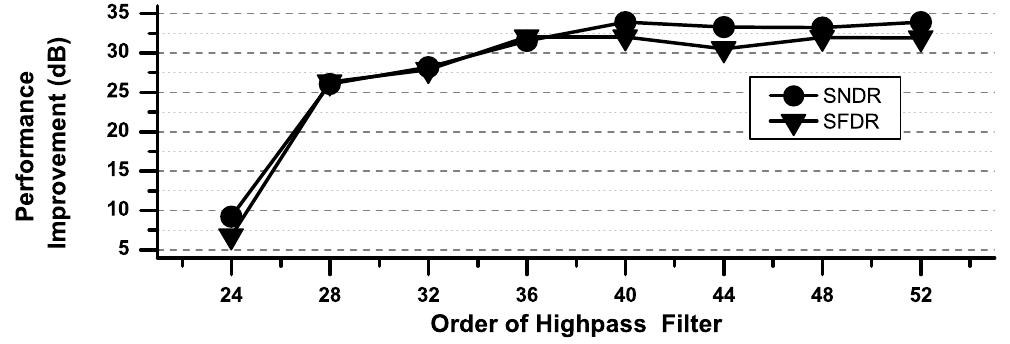
Figure 14. Performance (signal to noise and distortion ratio (SNDR) and spurious-free dynamic range (SFDR)) improvement under different orders of the high pass